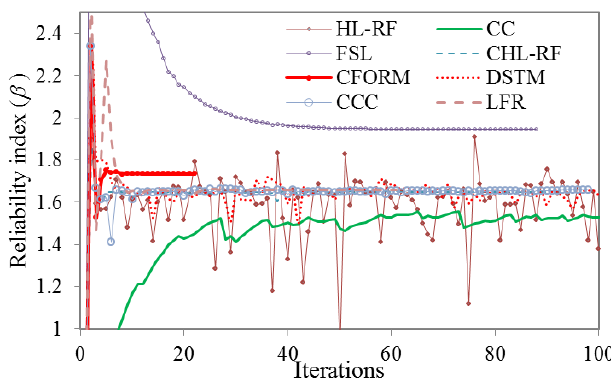
Figure 6. Iterative histories of HL-RF, FSL, CC, DSTM, CCC, LFR, CFORM, and CHL-RF in solving Example 3.